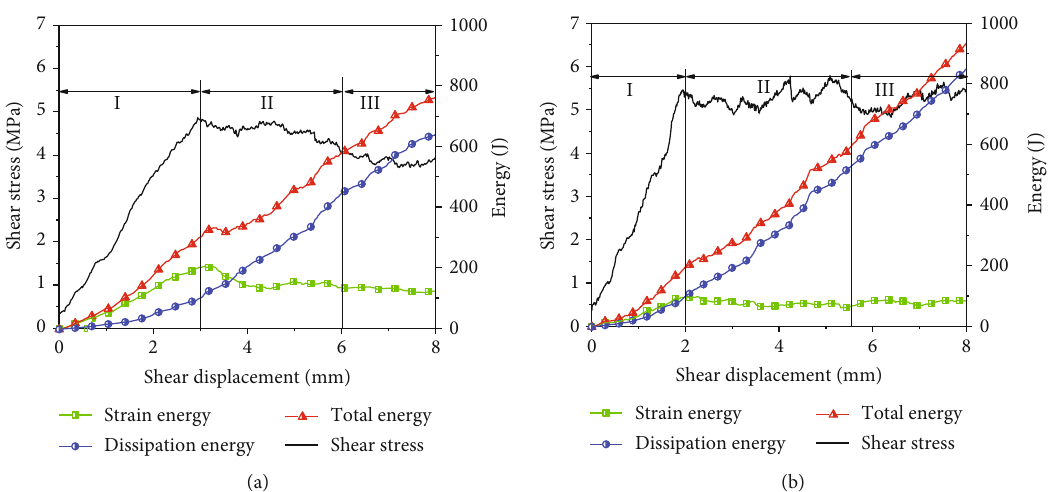
Figure 12: Variation curve of energy with shear displacement: (a) low-strength rock joints; (b) high-strength rock